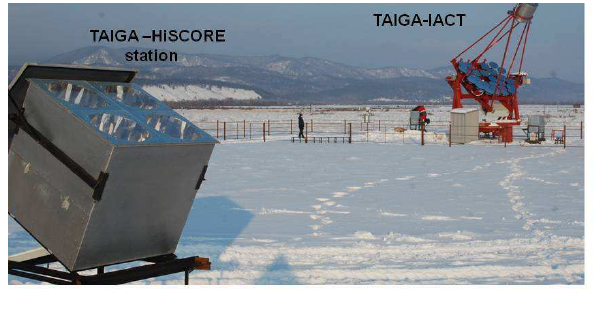
Figure 1. TAIGA-HiSCORE station and TAIGA-IACT